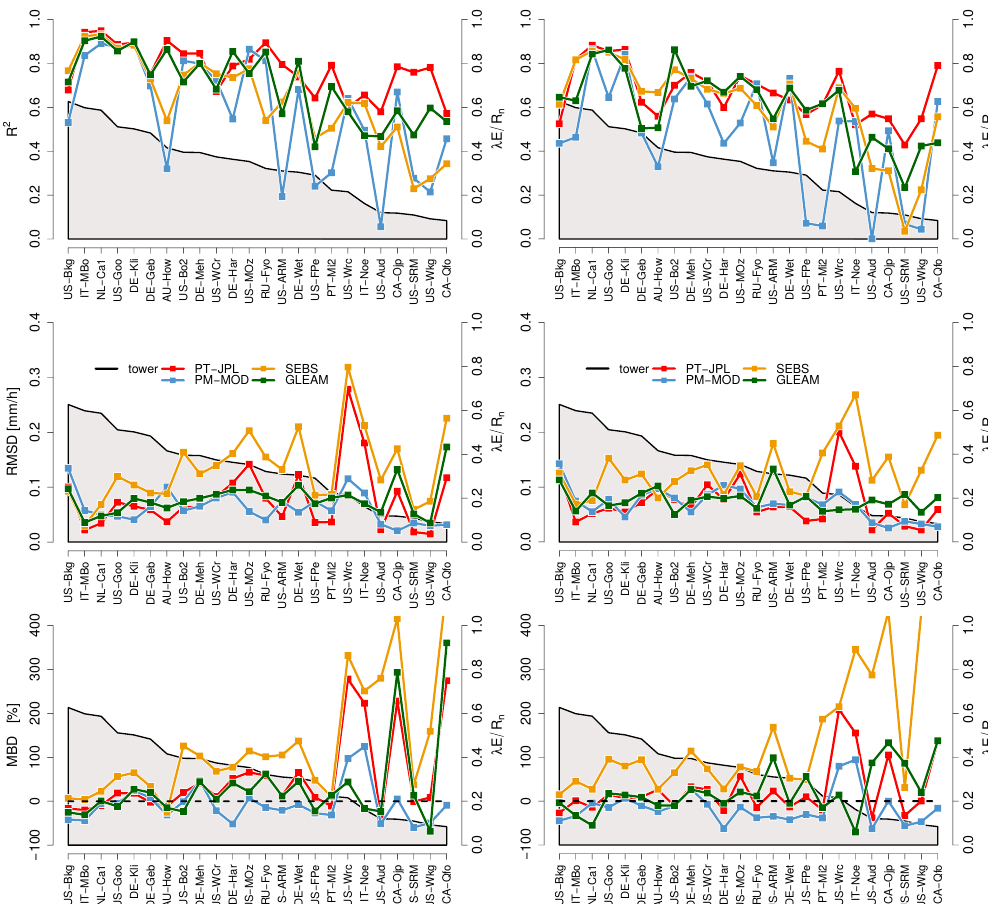
Figure 4. Station mean statistics of 3-hourly model data against EC reference. Left-column panels: tower-forced ET; right-column panels: satellite-forced ET; top-row panels: R 2 correlation coefficient (left y axis); middle-row panels: mean bias deviation (MBD, left y axis); bottom-row panels: root mean square difference (RMSD, left y axis). For all plots the evaporative fraction is given by the grey area (right y axis).